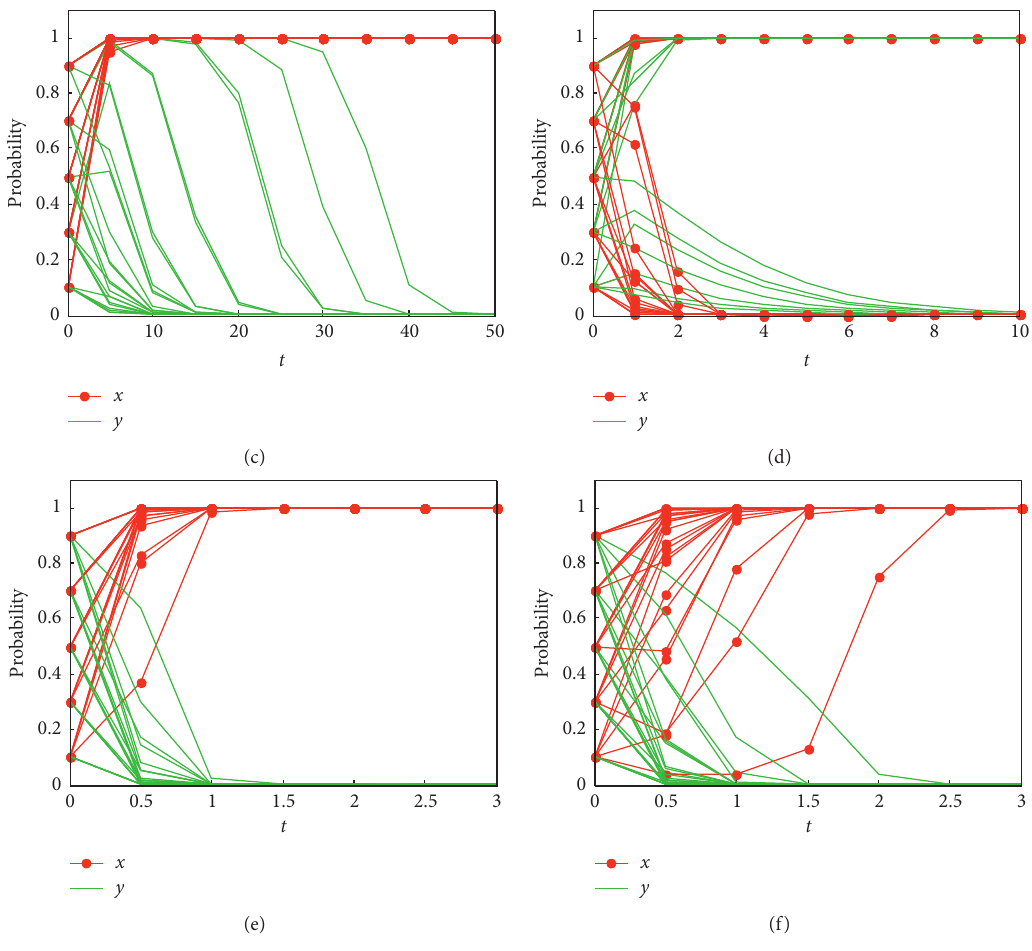
Figure 2: The simulation results of six